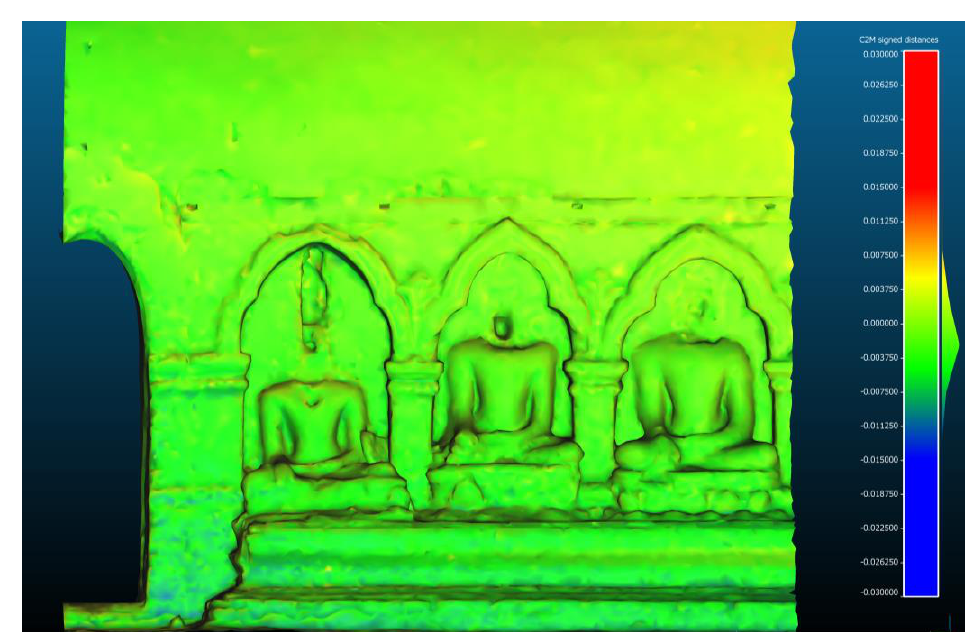
Figure 4. The deviation between the low poly and the medium poly models (in